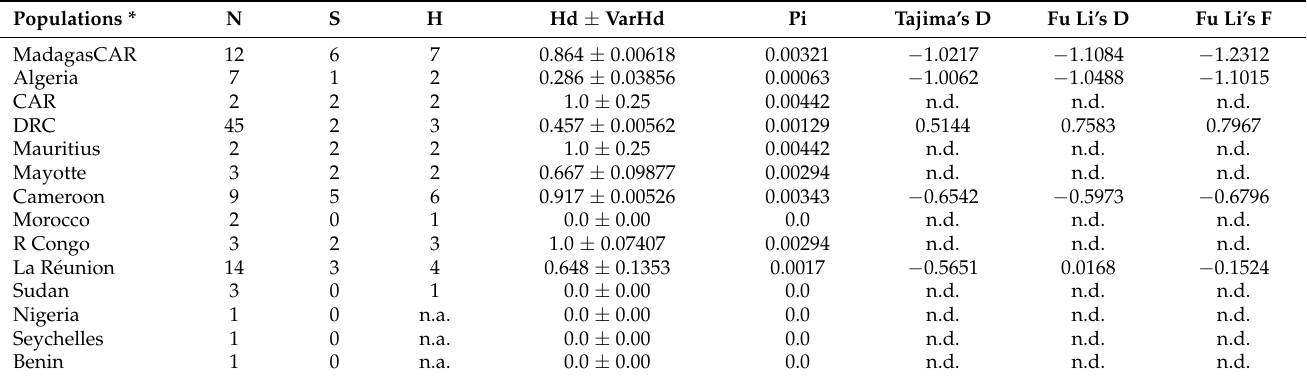
Table 1. Diversity and neutrality indices for Ae. albopictus populations in Africa calculated from the nucleotide datasets of the sequences available in the GenBank database at NCBI.